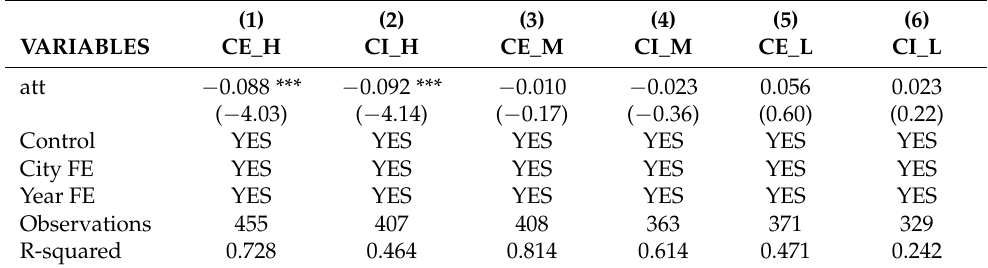
Table 14. Heterogeneity of talent agglomeration